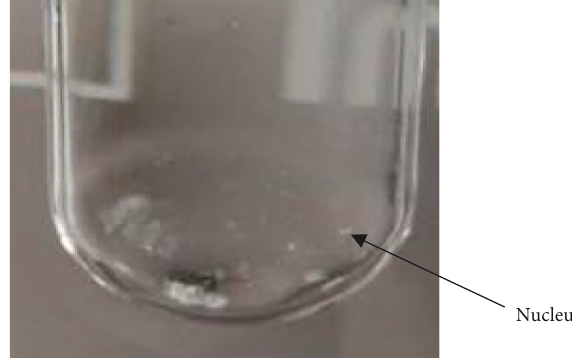
Figure 5: The photograph of sodium chloride